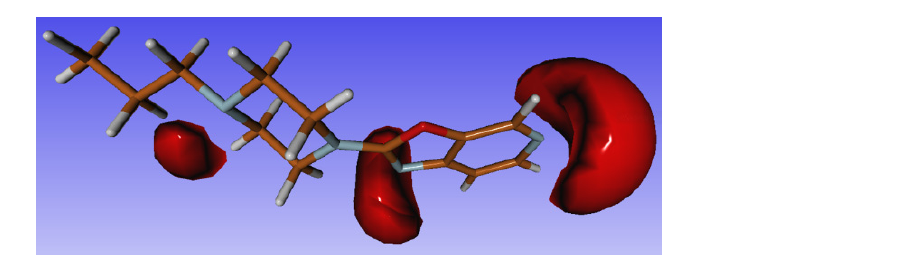
Figure 22. Isosurface of negative ( − 0.3) electrostatic potential calculated with MOLDEN (option: true electrostatic potential) for neutral molecule 3 in optimized geometry. Table 9. Energy of the optimized geometry of molecule 3 in the following different mono- protonated states: at N25, N29 and N11 nitrogen atoms, and CHELPG ESP fitted atomic charges for the optimized molecule 3 in unprotonated state.